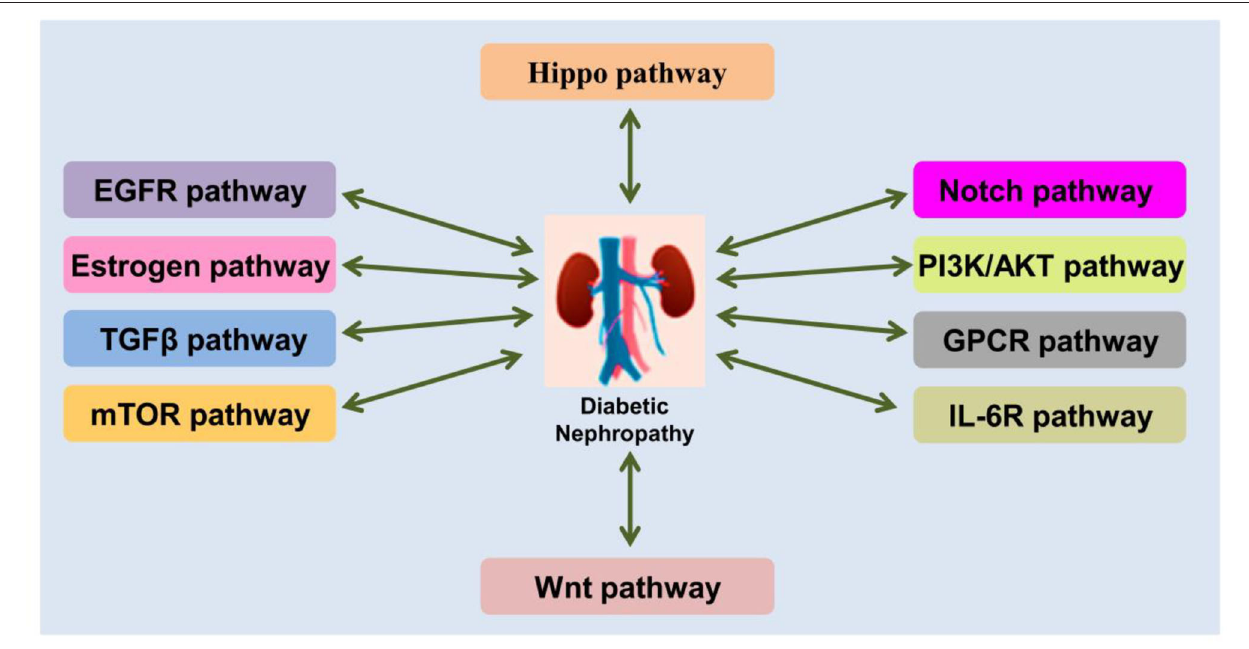
FIGURE 2 | Schematic demonstration of the crosstalks between DN and signaling pathways.